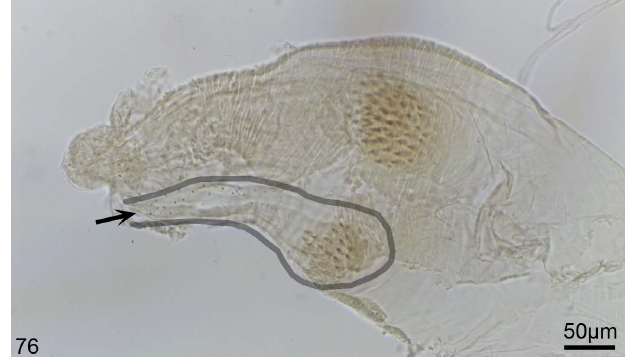
Fig 76. Enteric valve armature of Cylindrotermes sapiranga partially dissected, the musculature is partially removed, one of the three cushionsis highlighted in the figure.